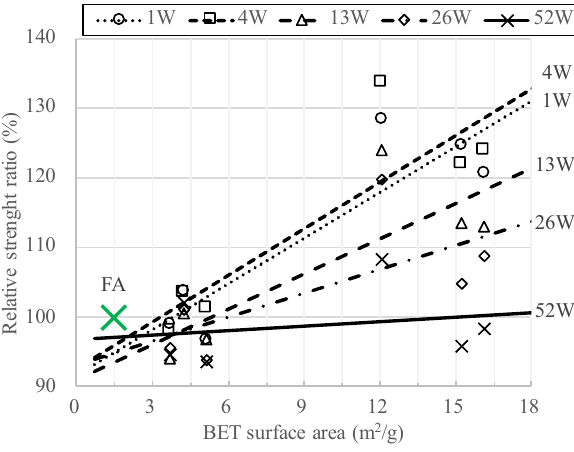
Fig. 20 VGP’s BET specific surface and the relative strength ratio to FA at W/B =